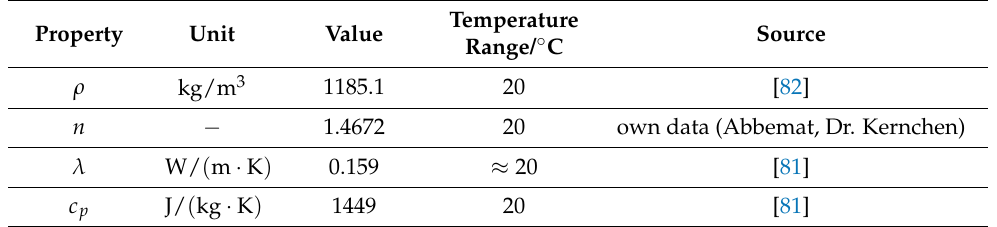
Table A2. Material properties of pure poly (vinyl